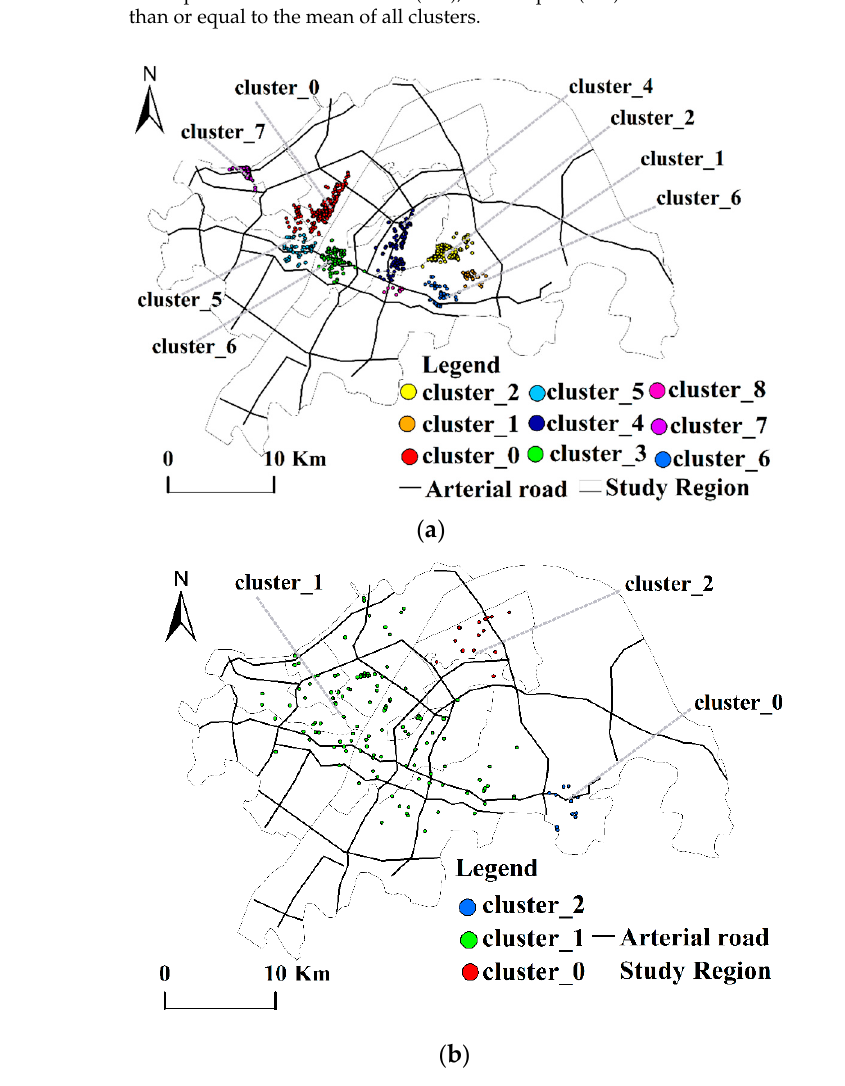
Figure 7. Spatial clustering distribution of the ecological elements. ( a ) Spatial clustering distribution of the parks and wetlands. ( b ) Spatial clustering distribution of the scenic spots.